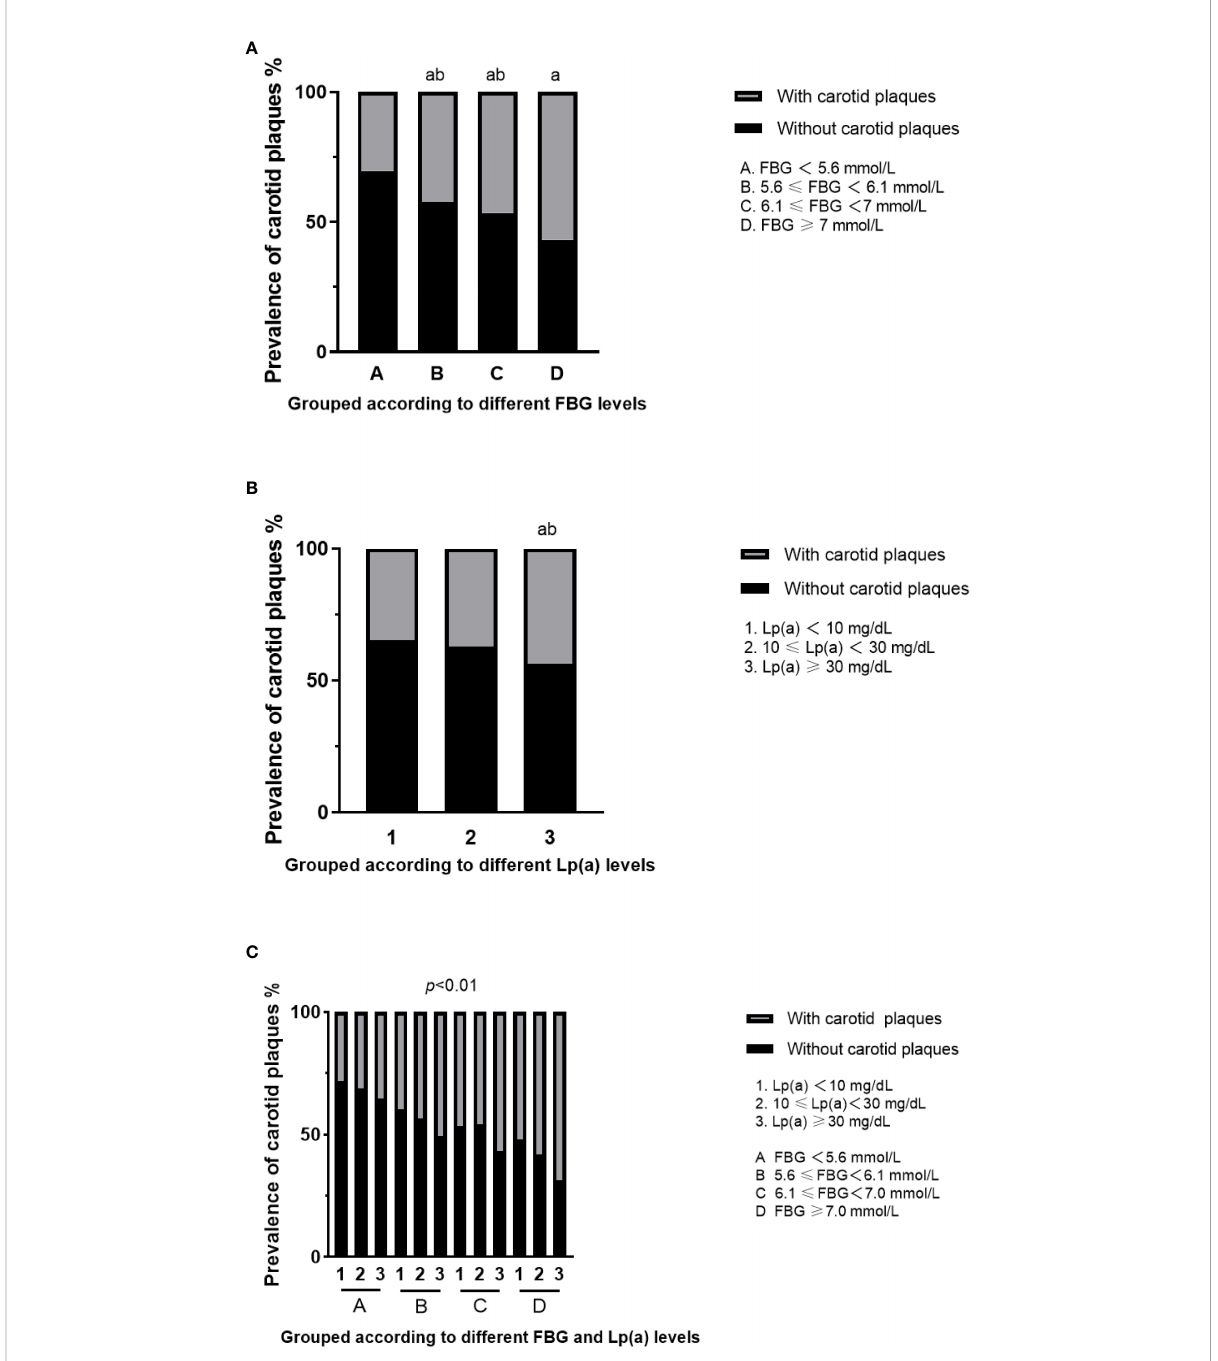
FIGURE 2 Prevalence of carotid plaques in fatty liver patients with different FBG and Lp(a) levels. (A) Prevalence of carotid plaques in fatty liver patients grouped according to different FBG levels. a For p <0.05 vs A group (FBG<5.6 mmol/L), b for p <0.05 vs D group (FBG>7.0 mmol/L). (B) Prevalence of carotid plaques in fatty liver patients grouped according to different Lp(a) levels. a For p <0.05 vs 1 group (Lp(a)<10 mg/dL), b for p <0.05 vs 2 group (10 ≤ Lp(a)<30 mg/dL). (C) Prevalence of carotid plaques in fatty liver patients with both different FBG and Lp(a) levels. FBG, fasting blood glucose; Lp(a),